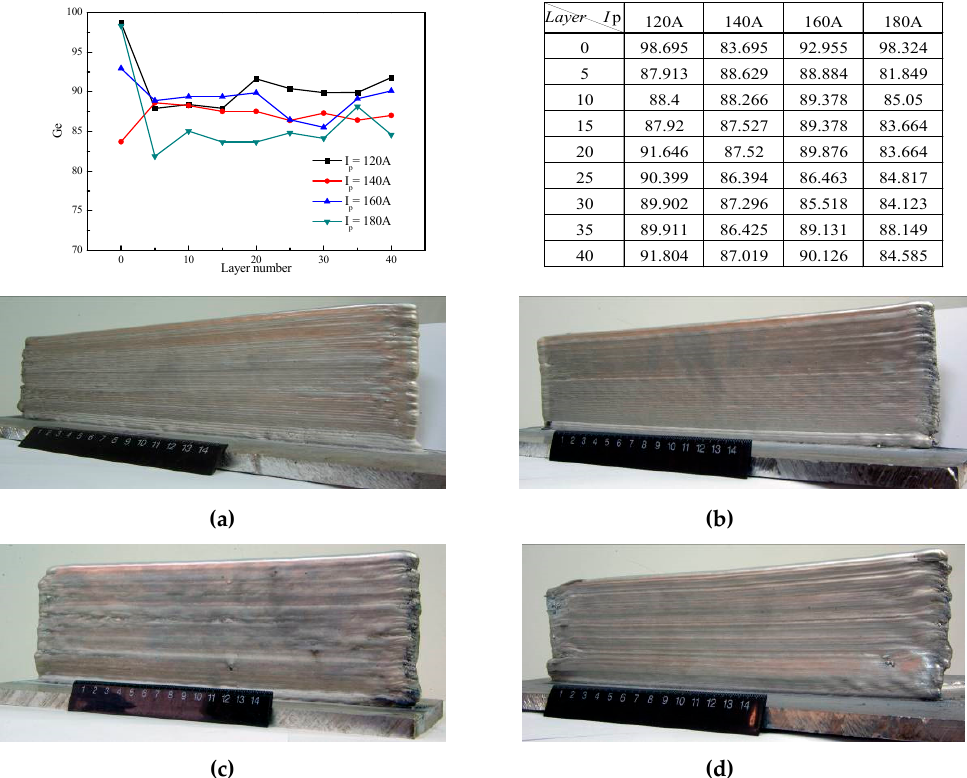
Figure 10. Ge number variation with layers deposited with different peak currents I P and the as-deposited wall part. ( a ) I p = 120 A; ( b ) I p = 140 A; ( c ) I p = 160 A and ( d ) I p = 180 A. Metals 2020 , 10 , 848 After five layers, the deposition process gradually becomes stable and the Ge number does not show a drastic change. For I p = 140 A, the average value of the Ge number is 87.7, and it shows the best numerical stability. Figure 10b shows the best wall surface appearance. In deposition with I p = 160 A, the Ge number had a data mutation in between the 20 and 30 layers of deposition, so uneven wall surfaces are visible in Figure 10c. The experimental results are consistent with analytical conclusions, which proves the validity of the Ge number as the indicator of deposition stability. The travel speed indicates heat allocation along the deposition path. Under the given heat sink